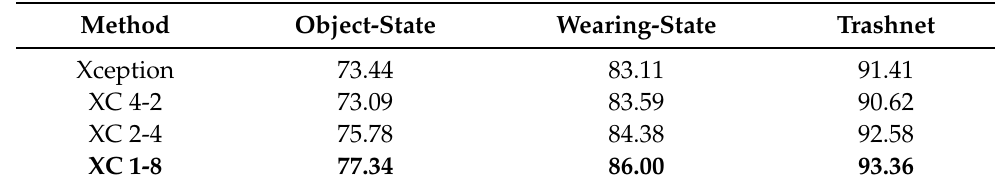
Table 4. Comparison of the performance (%) between the 4 structures without attention on our proposed two datasets and one common dataset.